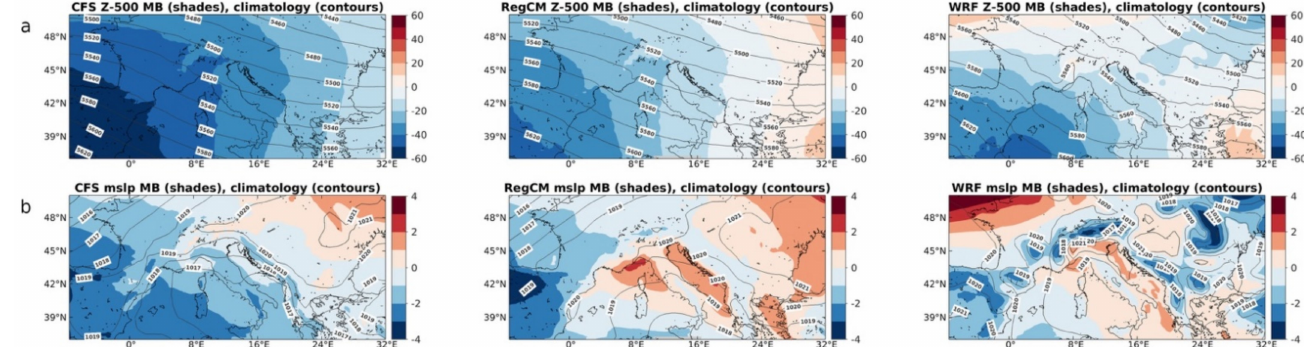
Figure 2. Reference period (1982–2002) mean values (contours) and mean bias on ERA5 (shades) for the geopotential eight at 500 hPa (Z-500, ( a )) and the mean sea level pressure (mslp, ( b )). Values correspond to the ensemble mean of the three SFSs. CFS results are reported in the left panel, RegCM central panels and WRF in the right panels. The units for the mean bias are m and hPa for Z-500 and mslp,